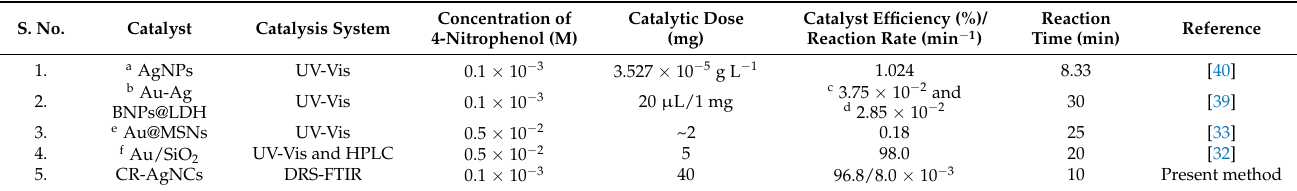
Table 2. Comparison of present method with other reported